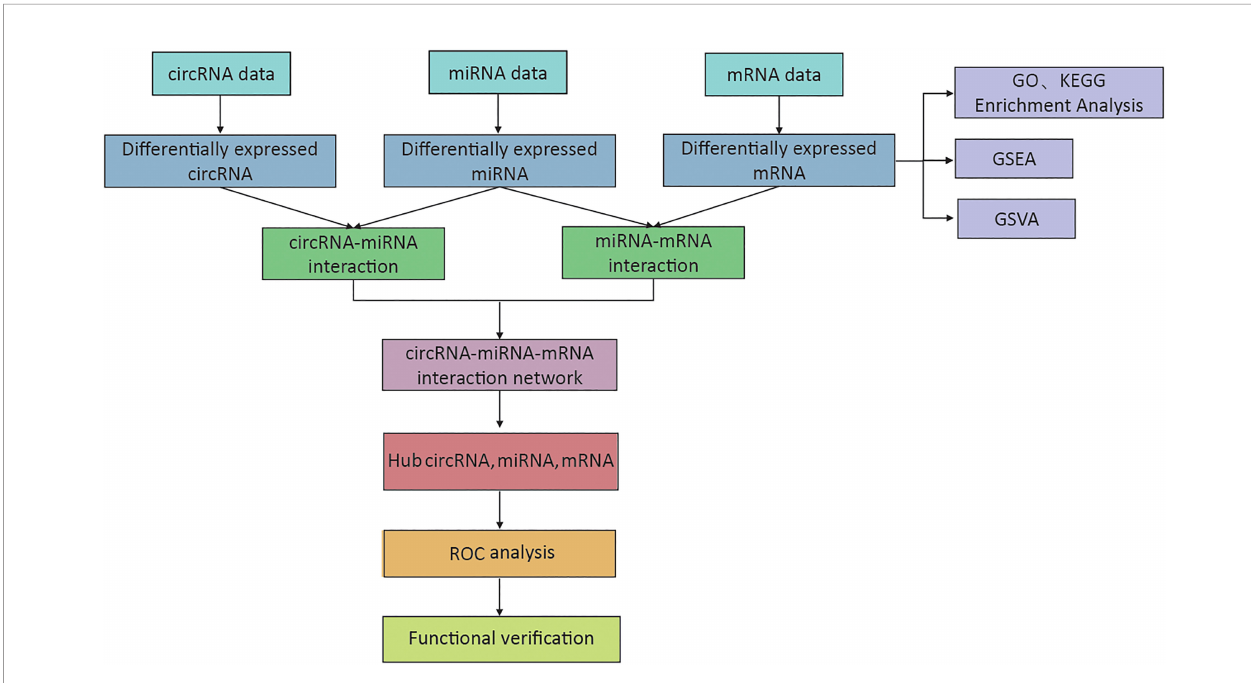
FIGURE 1 | The fl owchart of the whole research